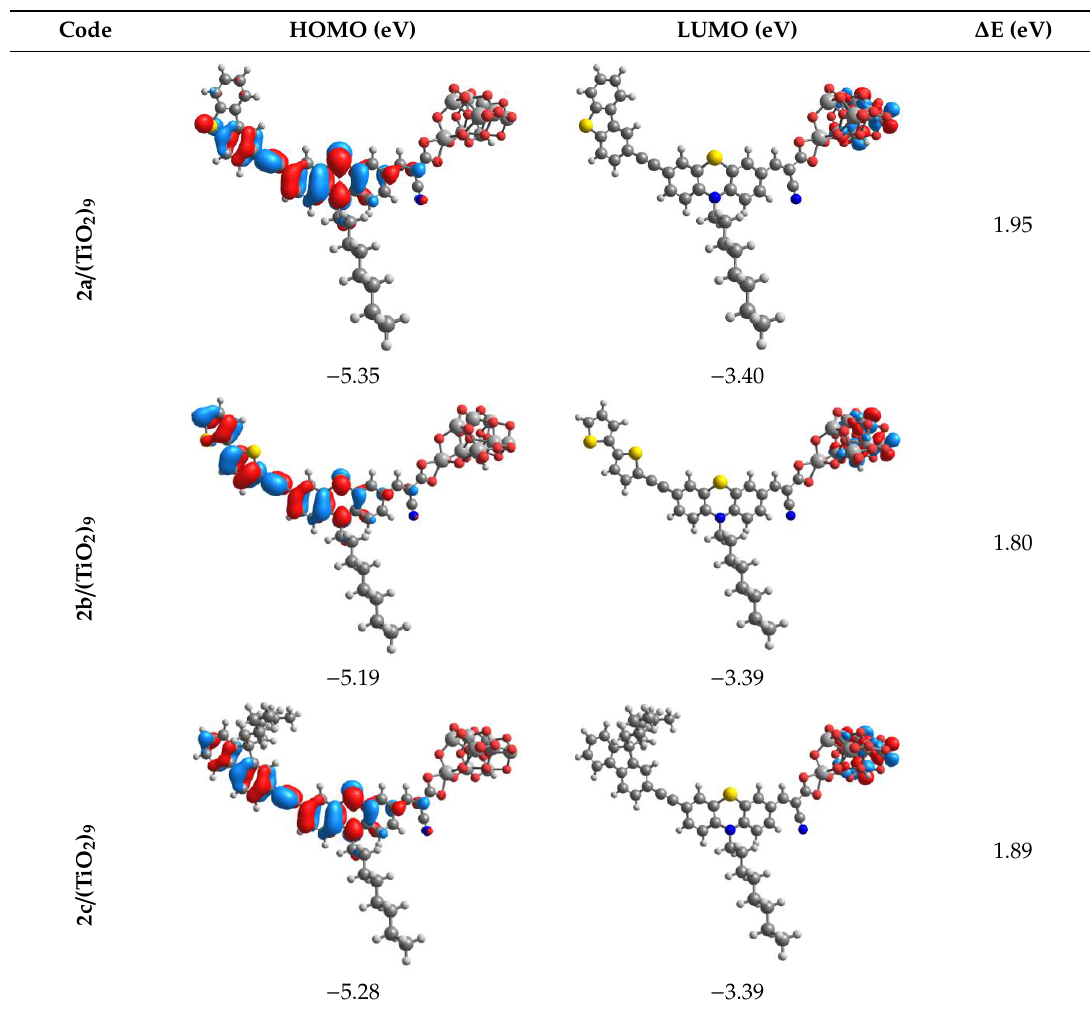
Table 3. The frontier orbitals with the percentage contributions of particular parts of the molecules to their creation, energies, and values of ∆ E of 2a–2c / (TiO 2 ) 9 .